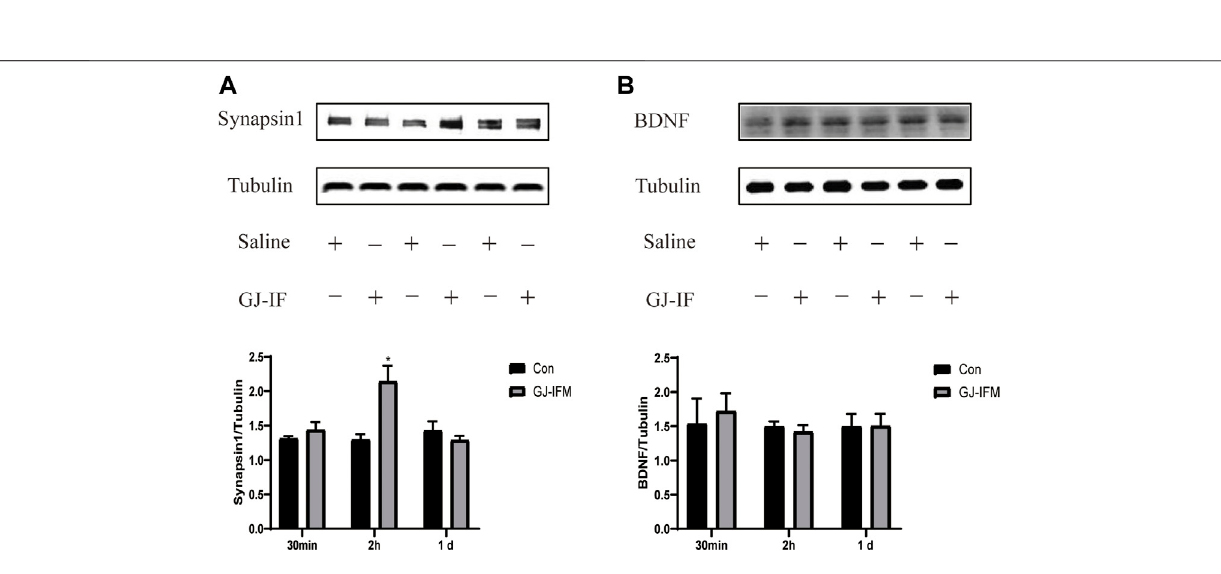
Frontiers in Pharmacology |